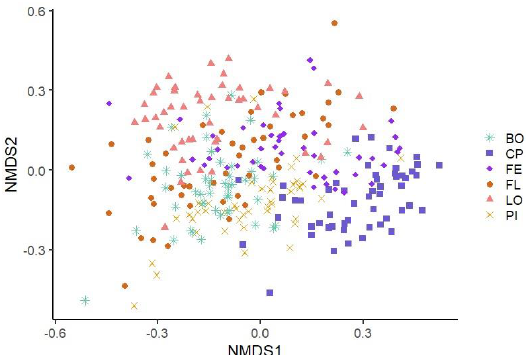
Figure 3. Non-Metric Multidimensional Scaling Graph (NMDS) of the microbiota structures of the six production line samples using Bray–Curtis index. Each point represents a sample, and each production line is represented by the combination of a symbol and a color. Turquoise star: Boston production line (BO); Blue square: Main production line (CP); Purple diamond: Ham production line (FE); Orange circle: Belly production line (FL); Pink triangle: Loin production line (LO); Yellow x: Picnic production line (PI).